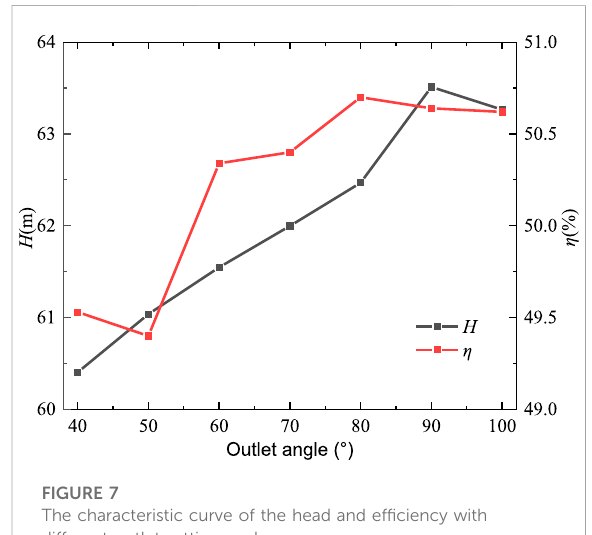
FIGURE 7 The characteristic curve of the head and ef fi ciency with different outlet setting angle.